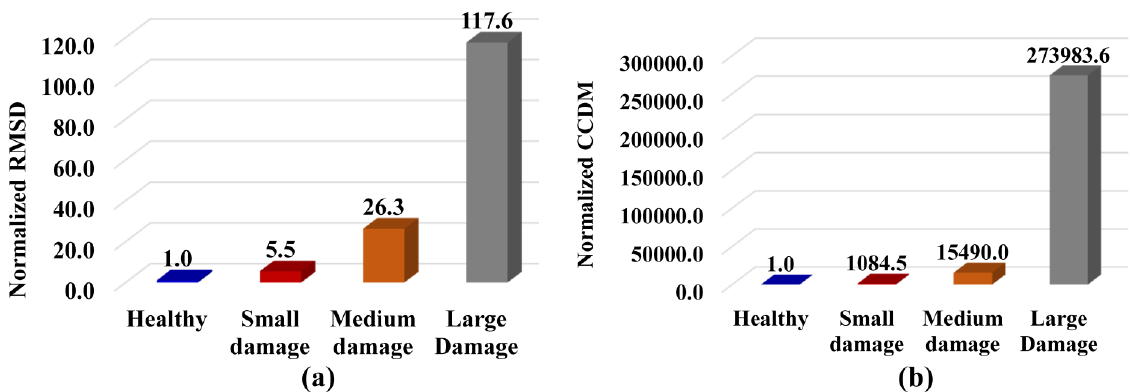
Figure 6. Normalized ( a ) RMSD and ( b ) CCDM indices for different damage